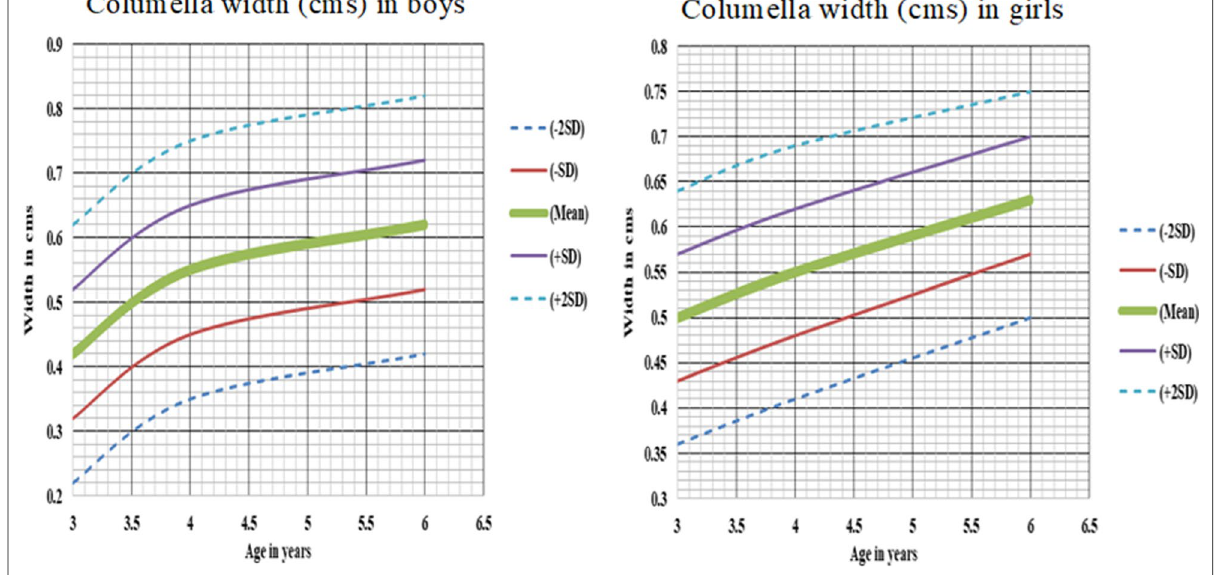
Fig. 10 Columella width (cm) in boys and girls